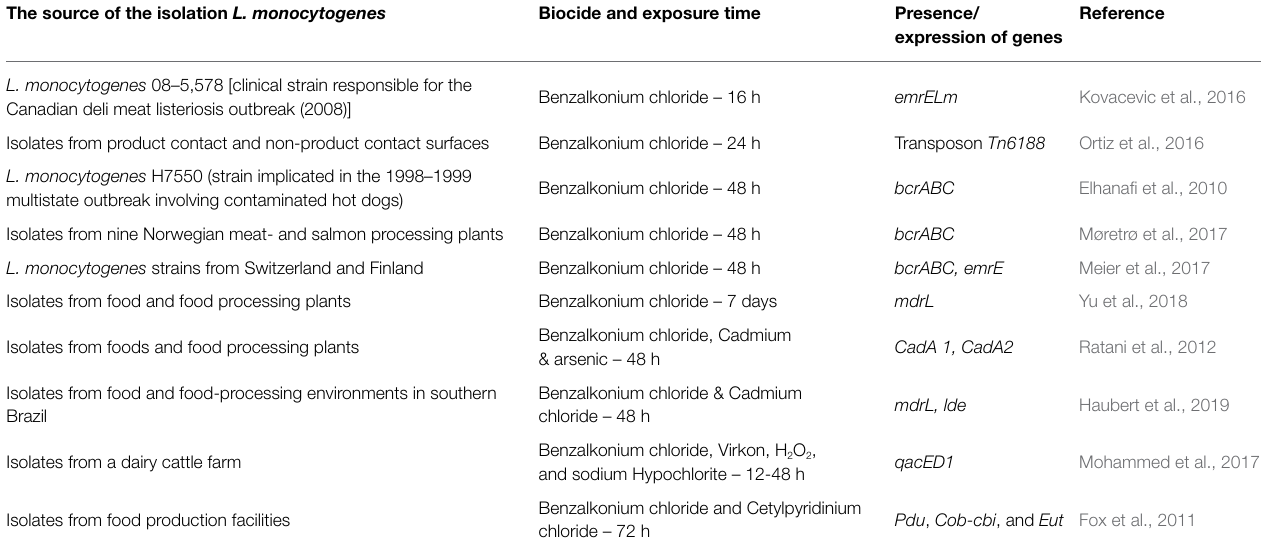
TABLE 3 | Genes involved in biocide tolerance in L. monocytogenes